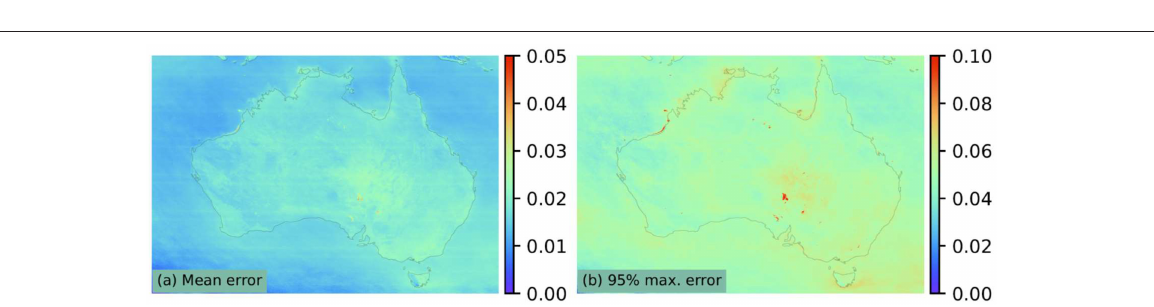
FIGURE 10 | Error characterization of the Australian region from 6 Jun 2015 to 30 Jun 2018 for daylight hours ( i.e., 22UTC to 8UTC or 8–18 Australian east standard time). Part (a) is the mean model error, defined by Equation (5), and (b) maximum error at the 95th